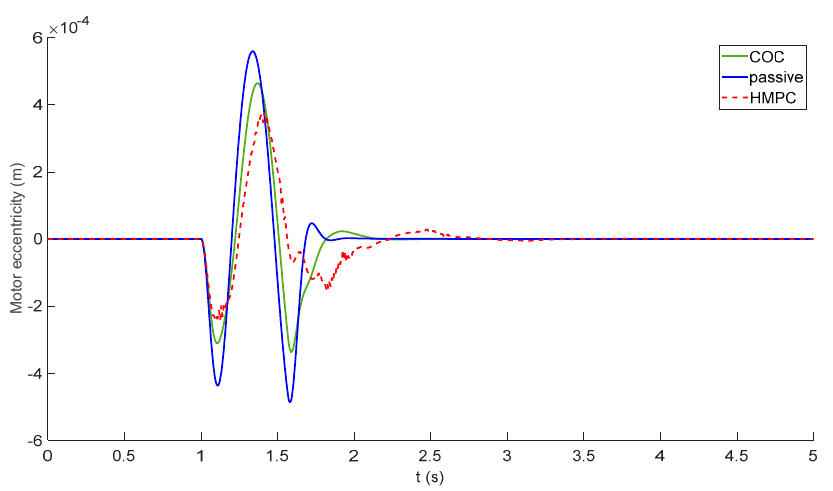
Figure 22. Motor eccentricity.